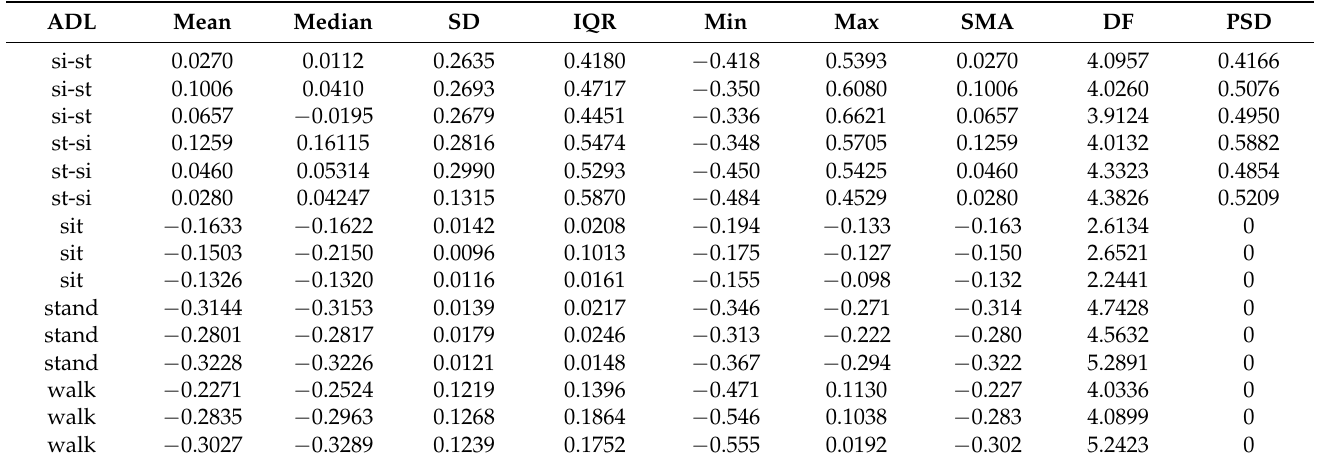
Table 5. Example for a dataset that contains the extracted time and frequency domain features for various activities ADL (activity daily